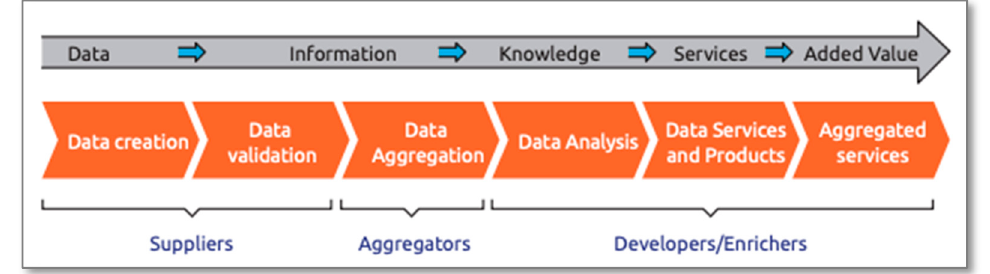
Figure 6. The data value chain and data value chain archetypes. Reproduced from reference [17], with permission from European Data Portal, 2017.